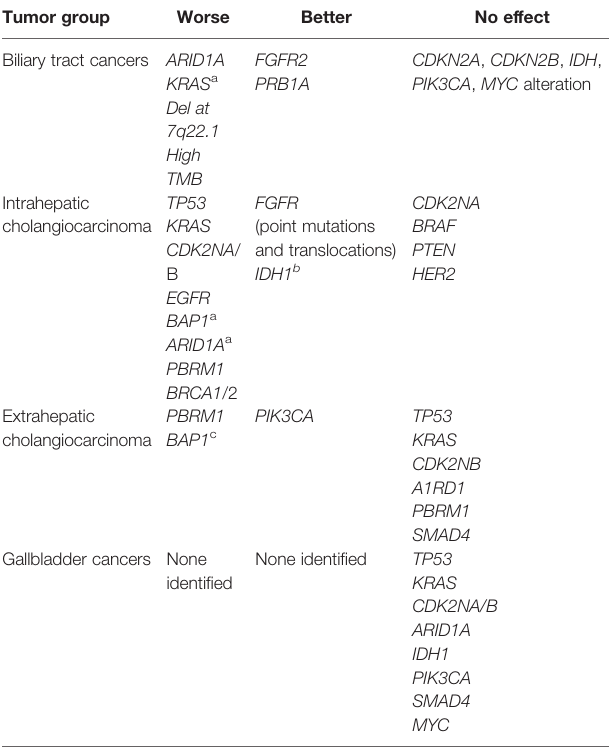
TABLE 2 | Somatic mutations and their prognostic value in biliary tract cancers. Tumor group